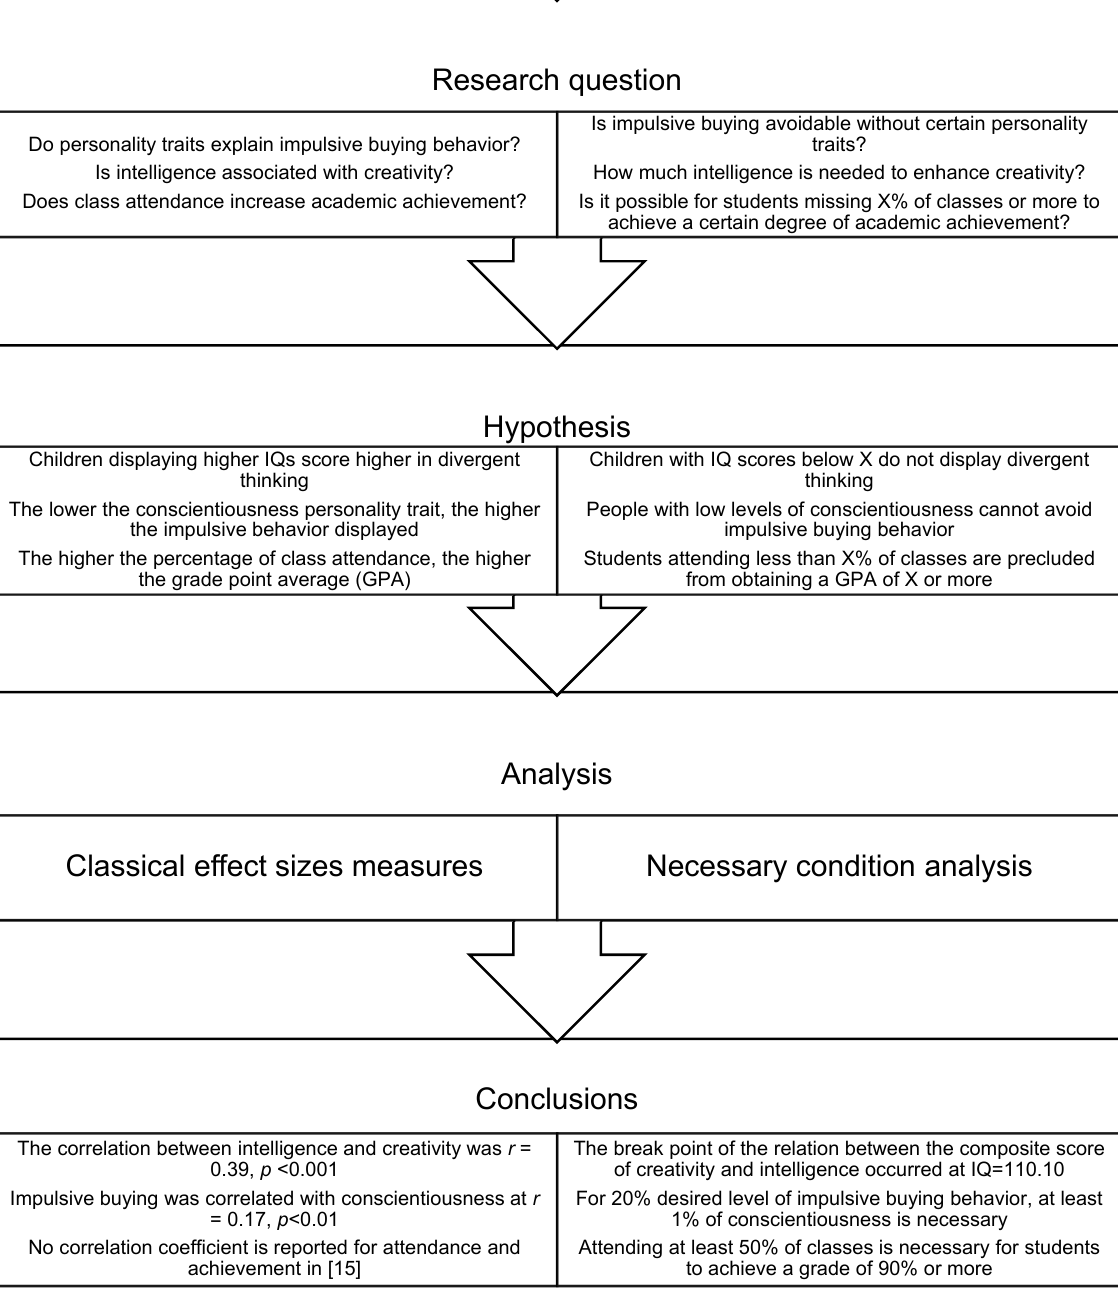
Figure 1. Examples of sufficiency and necessity logic are extracted from [15–17], respectively.